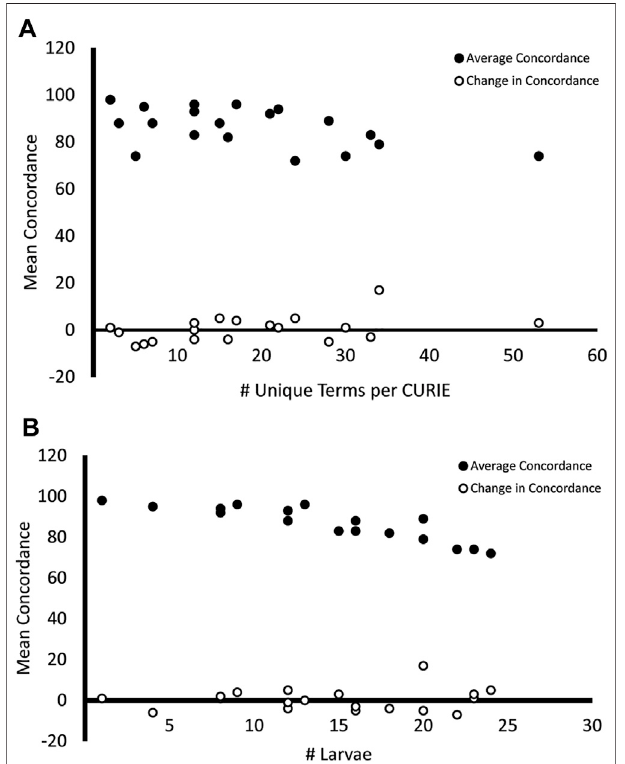
FIGURE 7 | Mean concordance and variability in endpoint reporting. Endpointsthatweredescribed using ahigher number ofuniqueterms (A) and wereobservedinmorelarvae (B) hadalowermeanconcordanceacrossboth surveys ( fi lled circles). The change in concordance from Survey 1 to Survey 2 did not share this relationship (open circles).